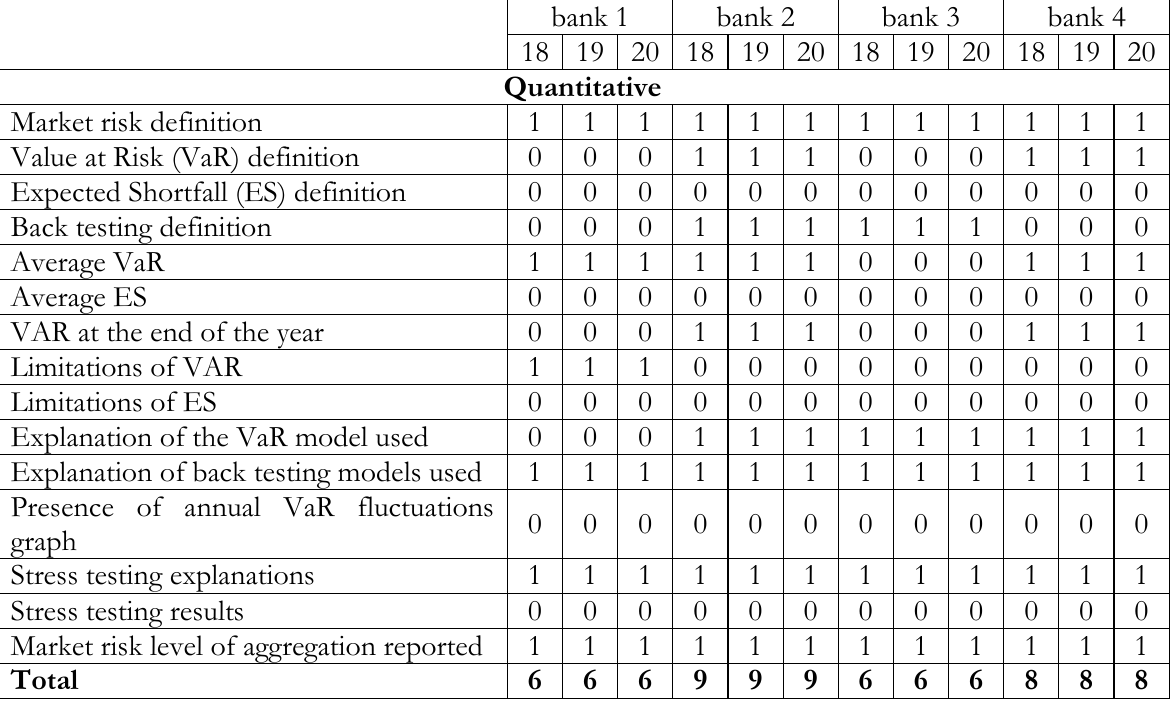
Table 1. Disclosure items and